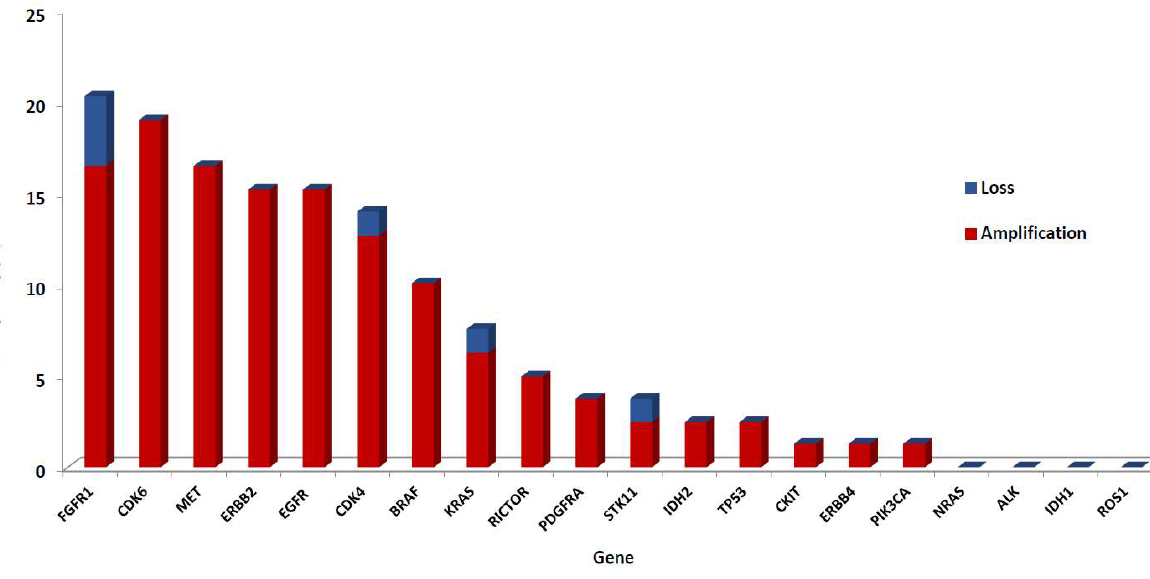
Figure 2. Bar chart of CNV frequency by gene in the 239 patients of the prospective cohort, including NSCLC, CRC, melanoma, GIST, esophagus, liposarcoma, and ovary tumors. Red—CNV amplifications and blue—CNV loss.